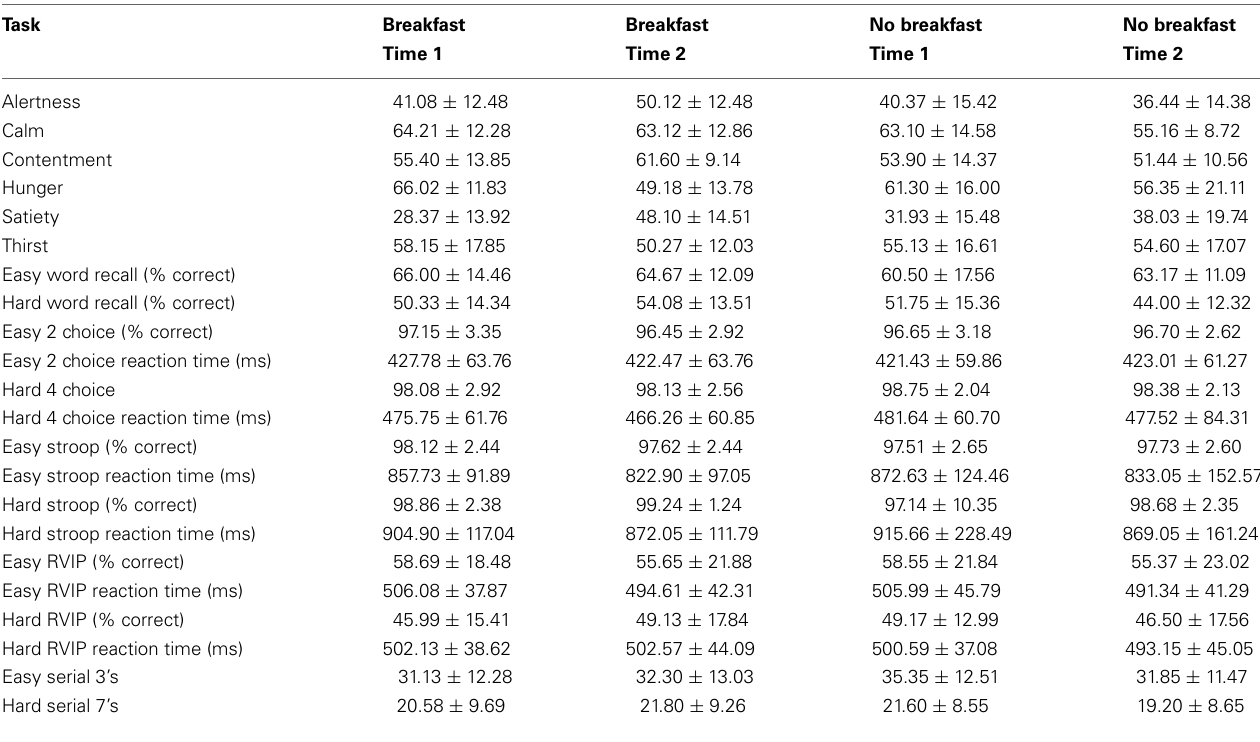
Table 2 | Performance on Mood dimensions, Hunger, Satiety, Thirst and on Cognitive Tasks as a factor of Breakfast and Test Time.